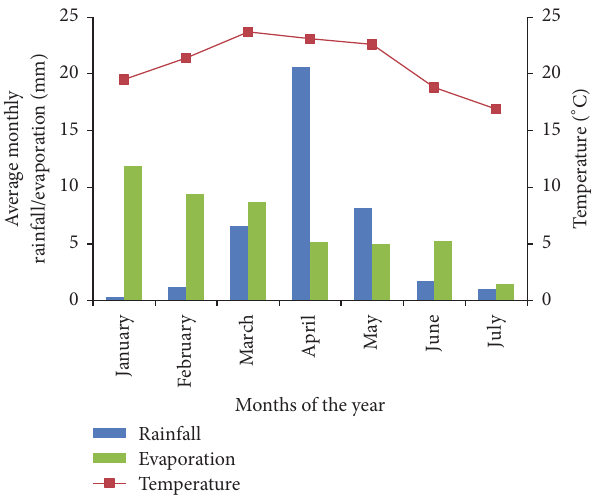
Figure 1: Weather data for the period January to July 2016 from SRI meteorological station about 200m from the experimental field.